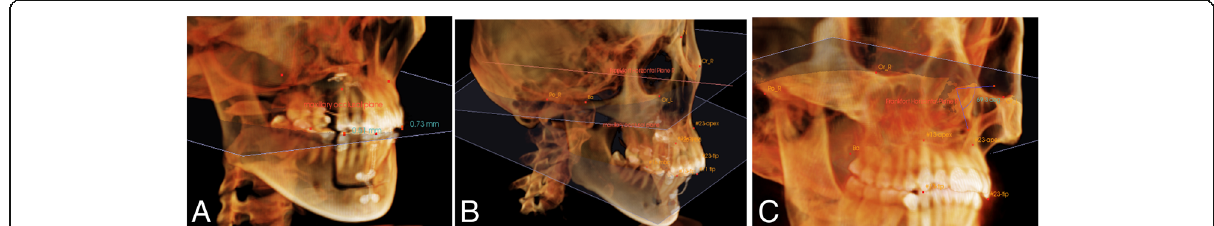
Fig. 3 Measurements on occlusal plane and maxillary canine changes. a Distance between occlusal plane and the U3CP. b . Occlusal plane angle to the FH-plane. c Long axis of the maxillary canine relative to the FH-plane